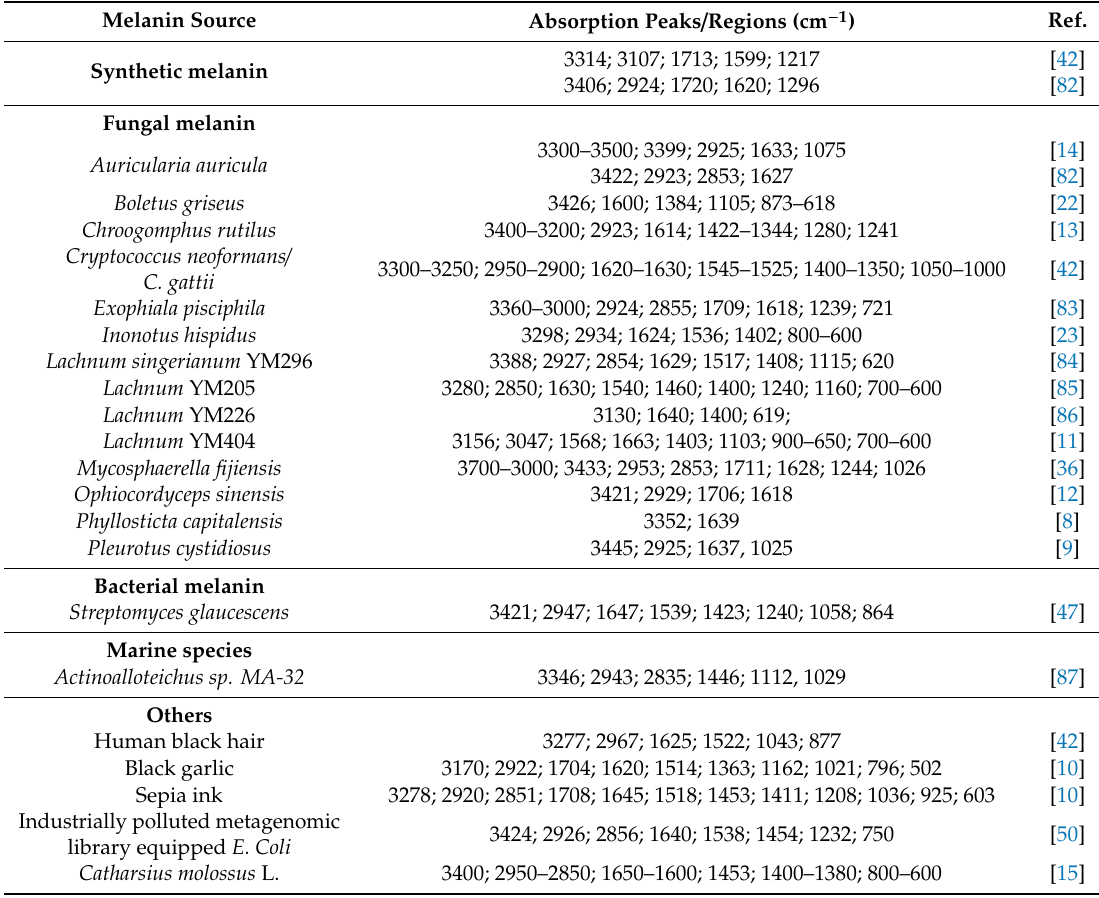
Table 7. The FTIR absorption bands reported for di ff erent